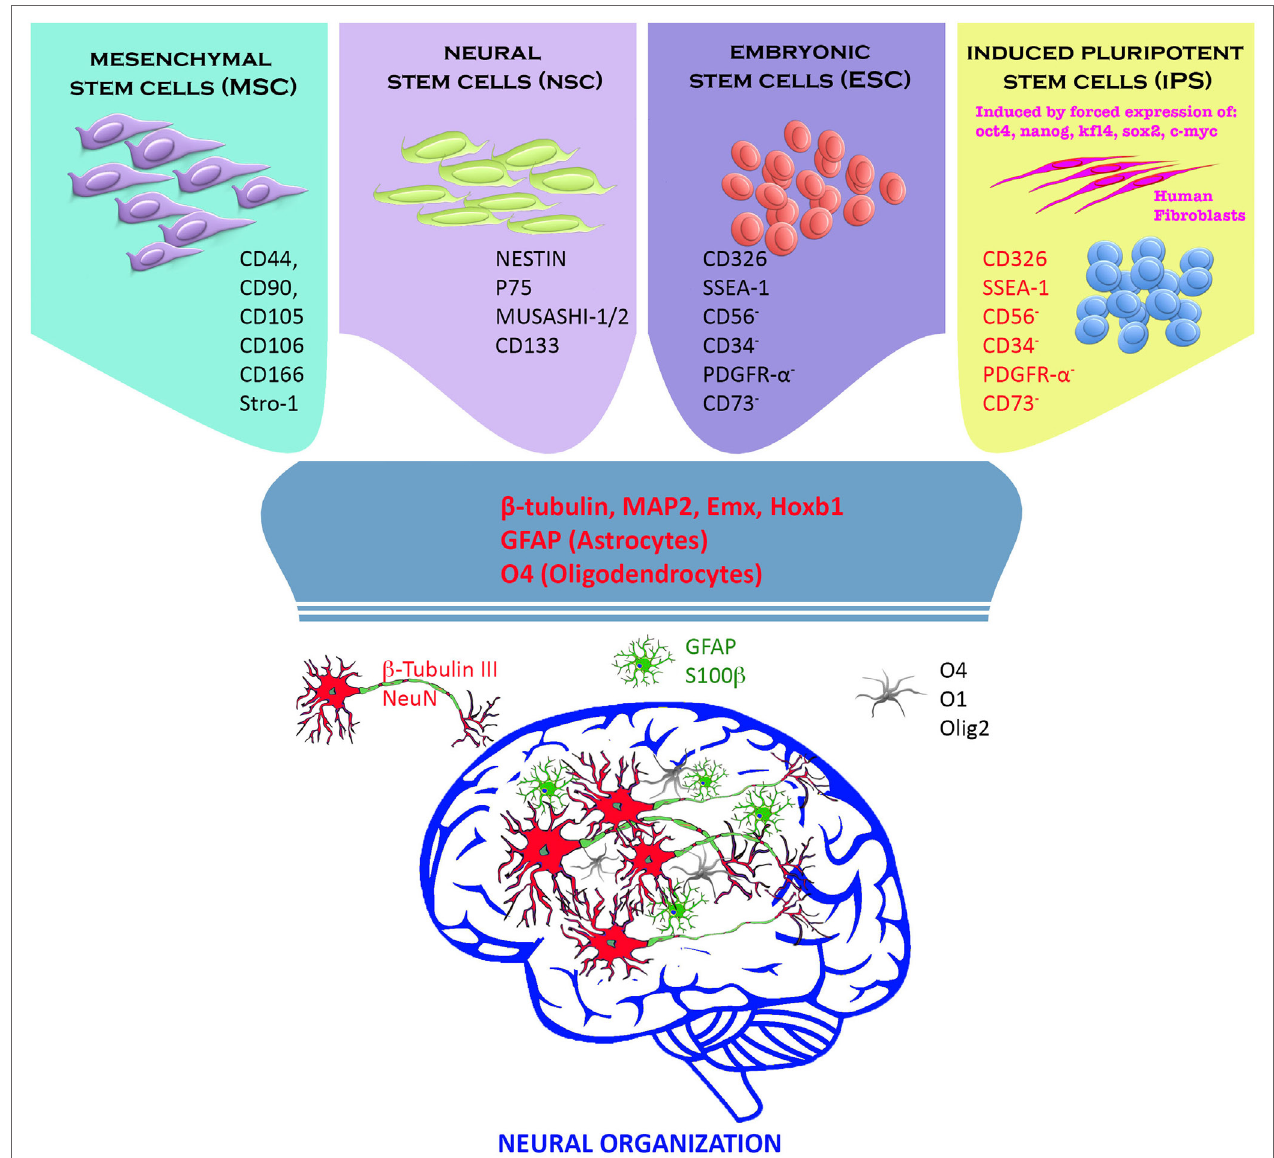
FigURe 1 | Stem cells and neural progenitor cells have been used to replace neural tissue death following a cerebral insult. Adult (mesenchymal and neural stem cells) and embryonic stem cells (ESCs) exhibited excellent differentiation capacity toward the neural phenotypes (neurons, oligodendrocytes, and astrocytes) in vitro and in vivo . In our view instead, induced pluripotent stem cells (iPSCs) constitute the greatest prospect for a future cell therapy. iPSCs are derived directly from the patient’s connective tissue through a small biopsy and exhibit the same properties of ESCs, overcoming the problems related to immune rejection, and bypassing the need for embryos. They can be generated in a patient-matched manner, implicating that each individual could have their own pluripotent stem cell line. Finally, iPSCs can be used in personalized drug discovery and to understand and deepen the patient-specific basis of disease (7–10).